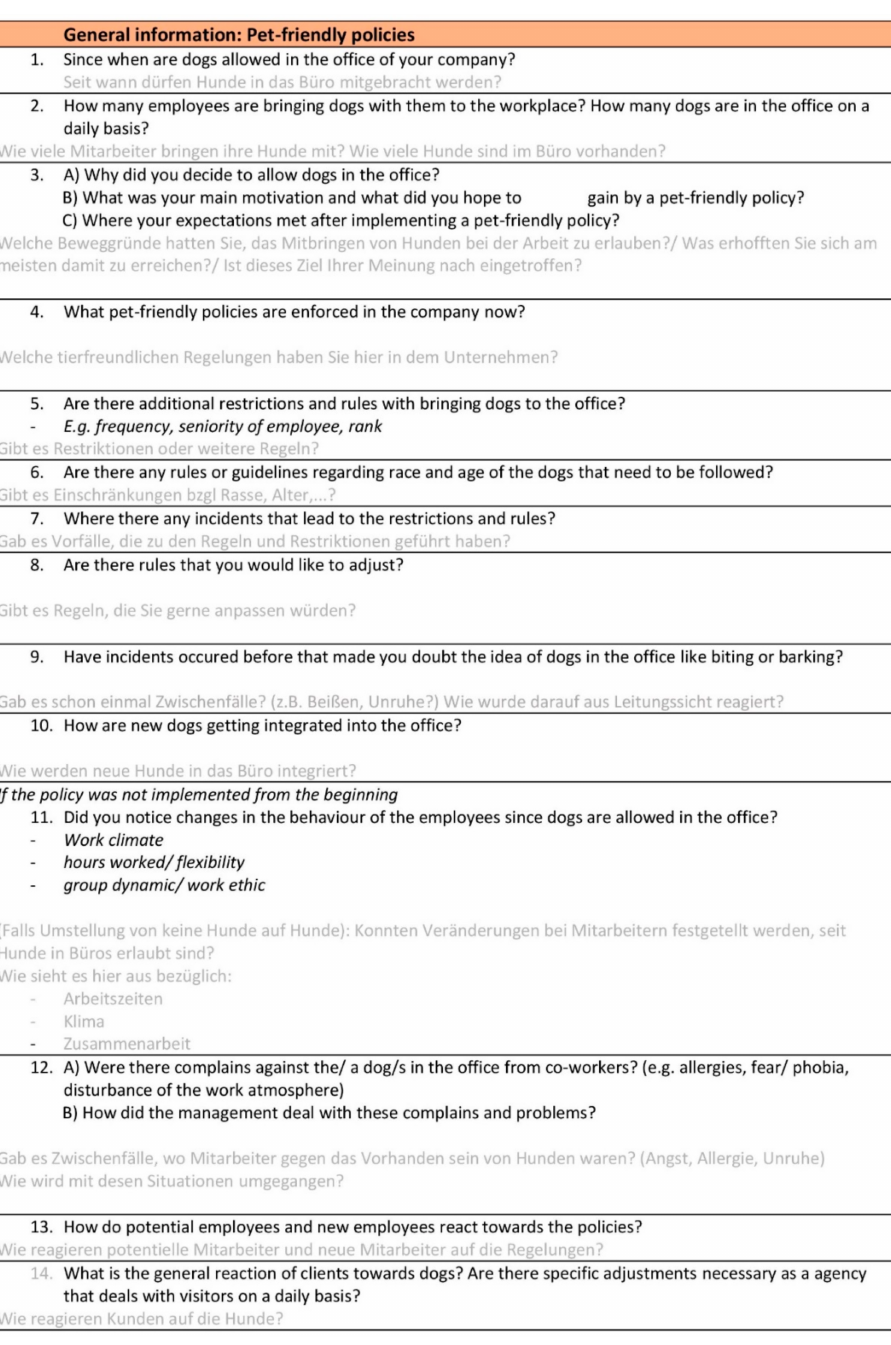
Figure 2. Interview guideline for